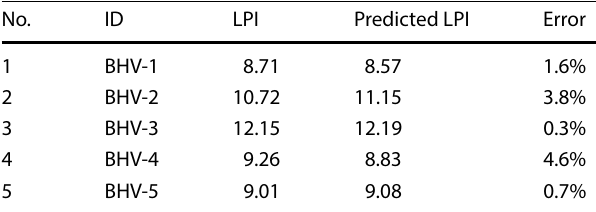
Table 8 Results of the ANN4 for the additional boreholes